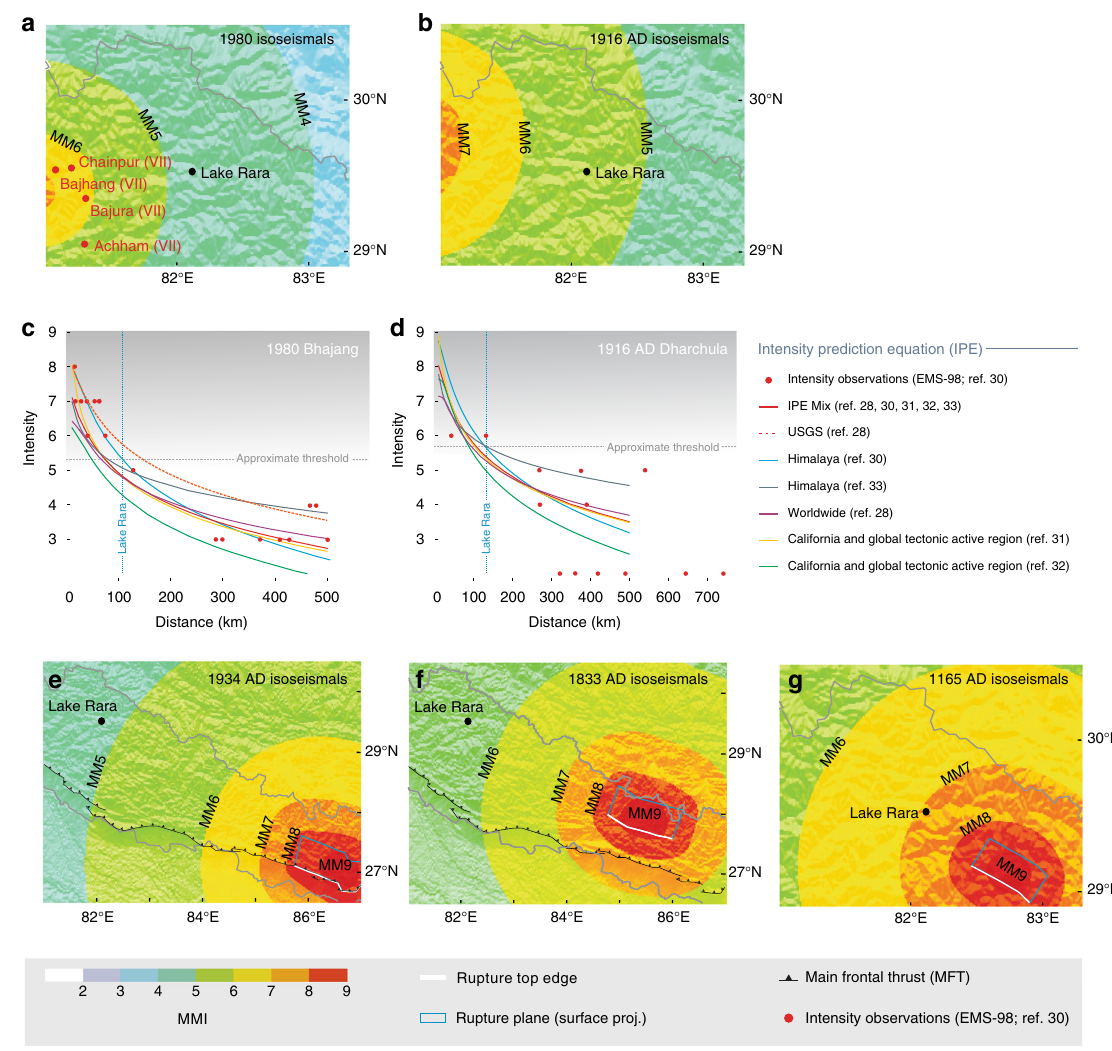
Fig. 3 Modi fi ed Mercalli Intensity isoseismals modelled for historical and instrumental earthquakes in central/western Nepal, and plots of observed and predicted intensity vs. distance. Modelled isoseismals and observed intensities for instrumental earthquakes in western Nepal; a 1980 (MHT?) Bhajang earthquake (modelled M w 6.5; intensity observations 28 in map region are indicated), b 1916 (MHT?) Dharchula earthquake (modelled M w 7.2; no intensity observations in map region). c , d Plots of observed and predicted intensity vs. distance for the 1980 Bhajang ( c ) and 1916 Dharchula ( d ) earthquakes, respectively. The vertical blue line corresponds to the epicentral distance of Lake Rara; the dashed grey lines indicate the lower ( c ) and upper ( d ) bounds of our approximate local earthquake turbidite-triggering threshold. Red dots are observed intensities 28 , coloured lines show predicted intensity vs. distance according to the different IPEs 28,29,31 – 33 and their average. Also shown is USGS Shakemap fi t for the 1980 Bhajang earthquake (see Methods for discussion). e – g Modelled isoseismals for historical earthquakes in central/western Nepal; e 1934 MHT earthquake (modelled M w 8.4), f 1833 MHT earthquake (modelled M w 7.7) and e 1165 – 1400 AD Tibrikot Fault (part of the WNFS) earthquake (modelled M w 7.9) The surface projection of the rupture plane is represented by the grey rectangle; the top edge of the rupture is shown by a solid white line. Rupture scenarios for e and f are from ref. 35 ; for g from ref. 37 . The location of Lake Rara is